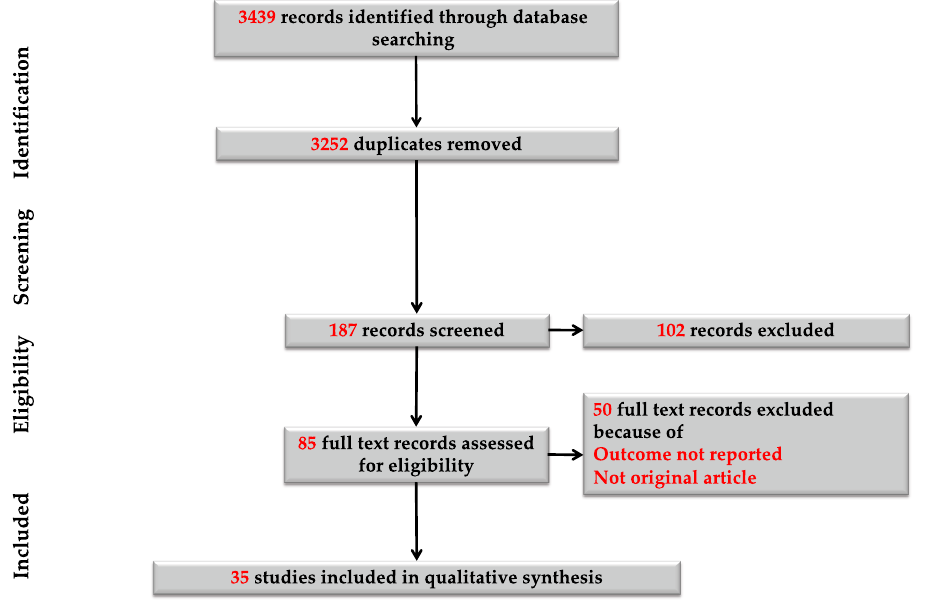
Figure 2. Flowchart depicting literature review and study